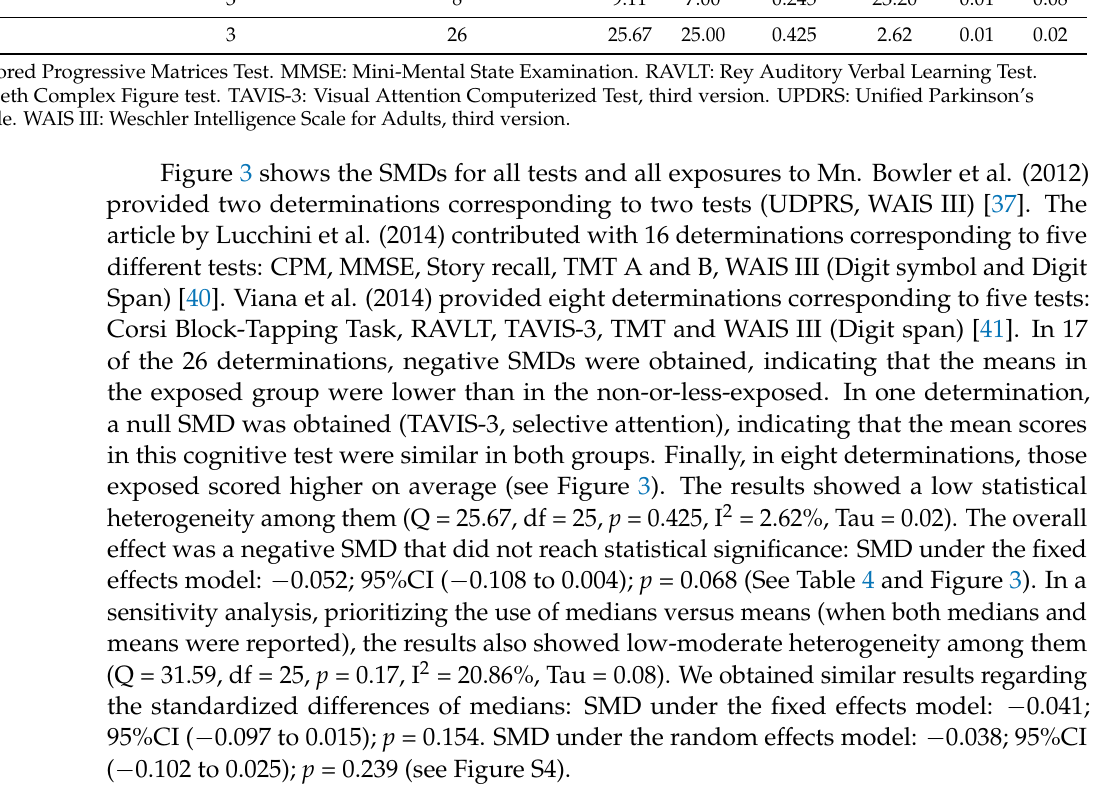
Table 4. Standardized mean differences (SMDs). Overall heterogeneity and as a function of the cognitive test used. Cognitive Function N of Studies N of Determinations SMD Corsi Block-Tapping